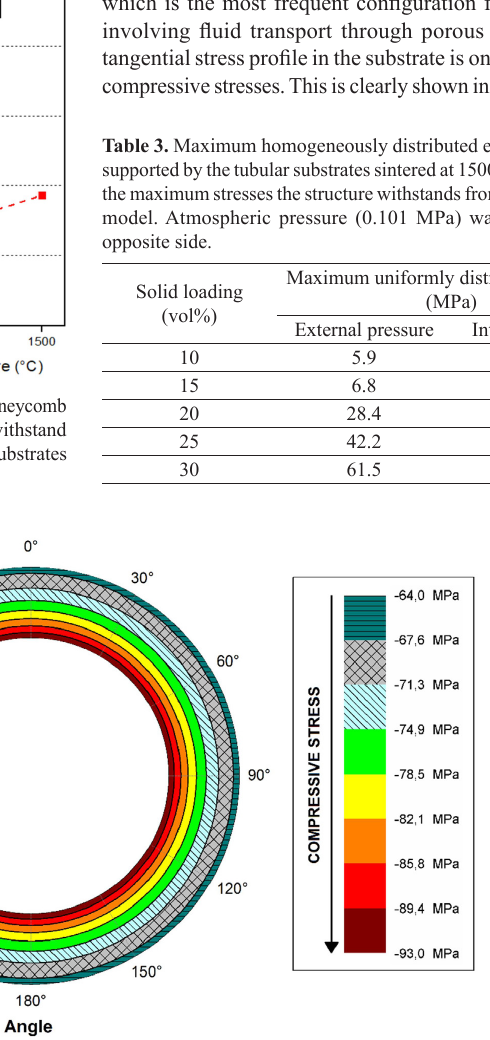
Figure 9. Tangential stress distribution in the tube with 20% solid loading and sintered at 1500 °C under maximum uniformly distributed external